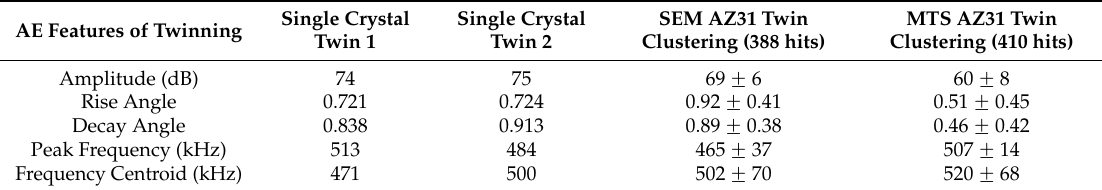
Table 1. Comparison of AE features related to twinning activity in